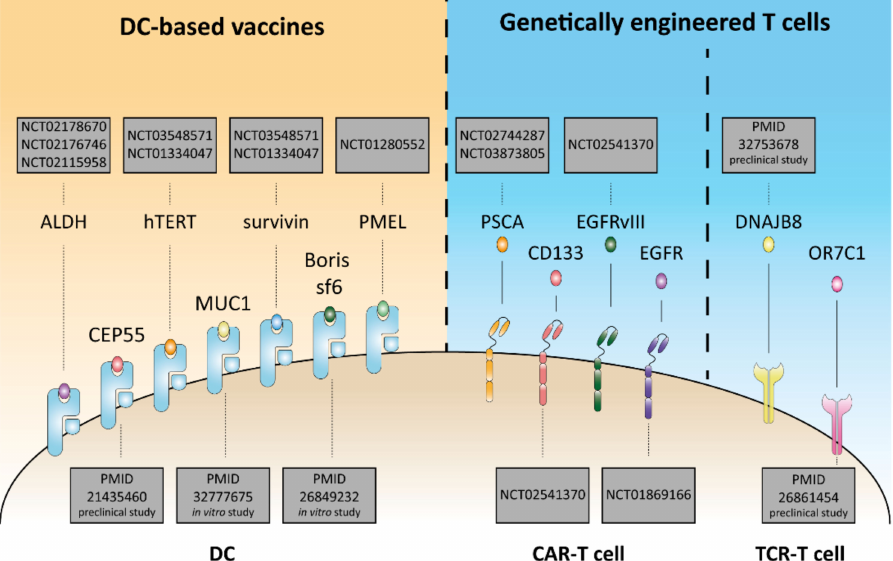
Figure 2. Immunotherapeutic targeting of CSC antigens. Cancer stem cells (CSCs) express several tumor-associated antigens (TAAs). CSCs are selectively targeted by means of dendritic cells (DCs) and genetically modified T cells (T cell receptor (TCR) T cells and chimeric antigen receptor (CAR) T cells). DC-based vaccines consist of DC expansion and loading with CSC specific antigen to prime CD8 + T cells, which, in turn, recognize and eliminate CSCs. TCR-engineered T cells are T cells equipped with a genetically modified TCR that specifically recognizes tumor antigen presented by human leukocyte antigen-A, B, C (HLA-A, B, C) on the surface of CSCs. CAR-T cells are T cells engineered to express a CD3 ζ intracellular domain joined to an antibody receptor that recognizes tumor antigens exposed on CSC surface in an HLA-unrestricted manner. Some TAAs, such as aldehyde dehydrogenase (ALDH), human telomerase (hTERT) and survivin, and a cancer testis, (CT) antigen such as premelanosome protein (PMEL), are under clinical